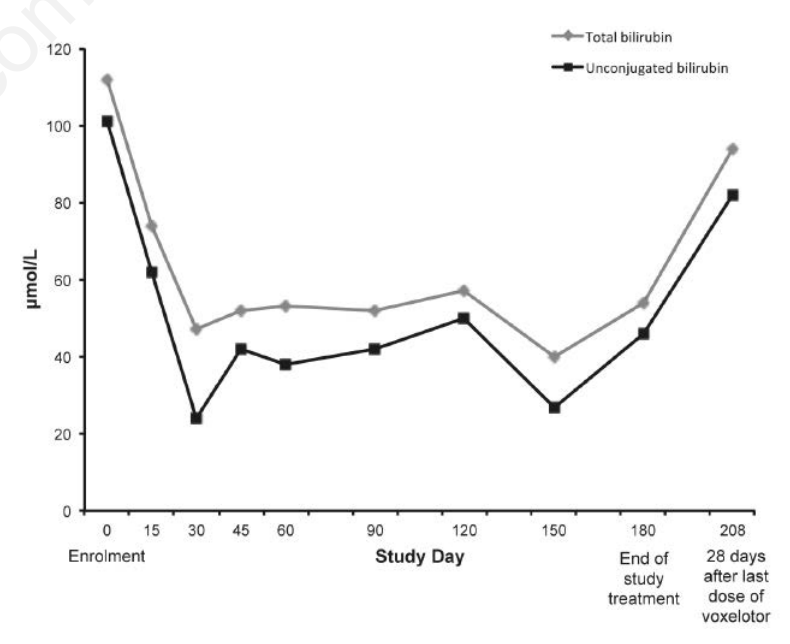
Figure 1. Total and unconjugated bilirubin over time with voxelotor treatment. Normal range values are 3-22 µmol/L (0.2-1.3 mg/dL) for total bilirubin and 3-17 µmol/L (0.2- 1.0 mg/dL) for unconjugated